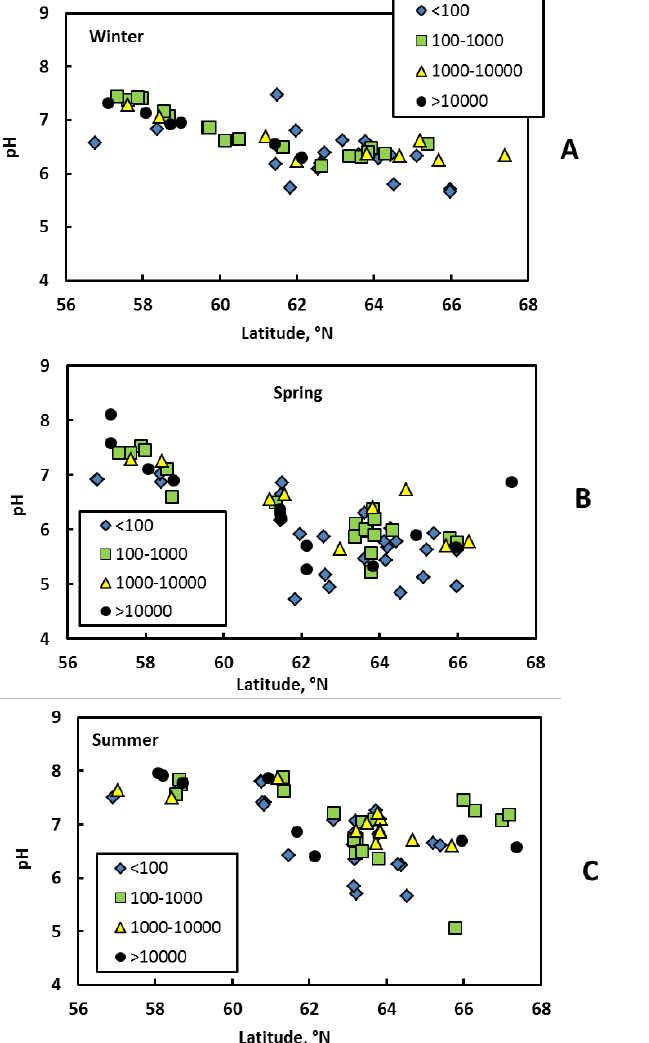
Figure 3. Decrease in DOC with latitude during winter (a) , spring (b) and summer (c) . The latitudinal trend is significant at p < 0.05. Considering all seasons together, the differences between different watershed sizes are not statistically significant ( p > 0.05). The sym- bols are the same as in Fig.